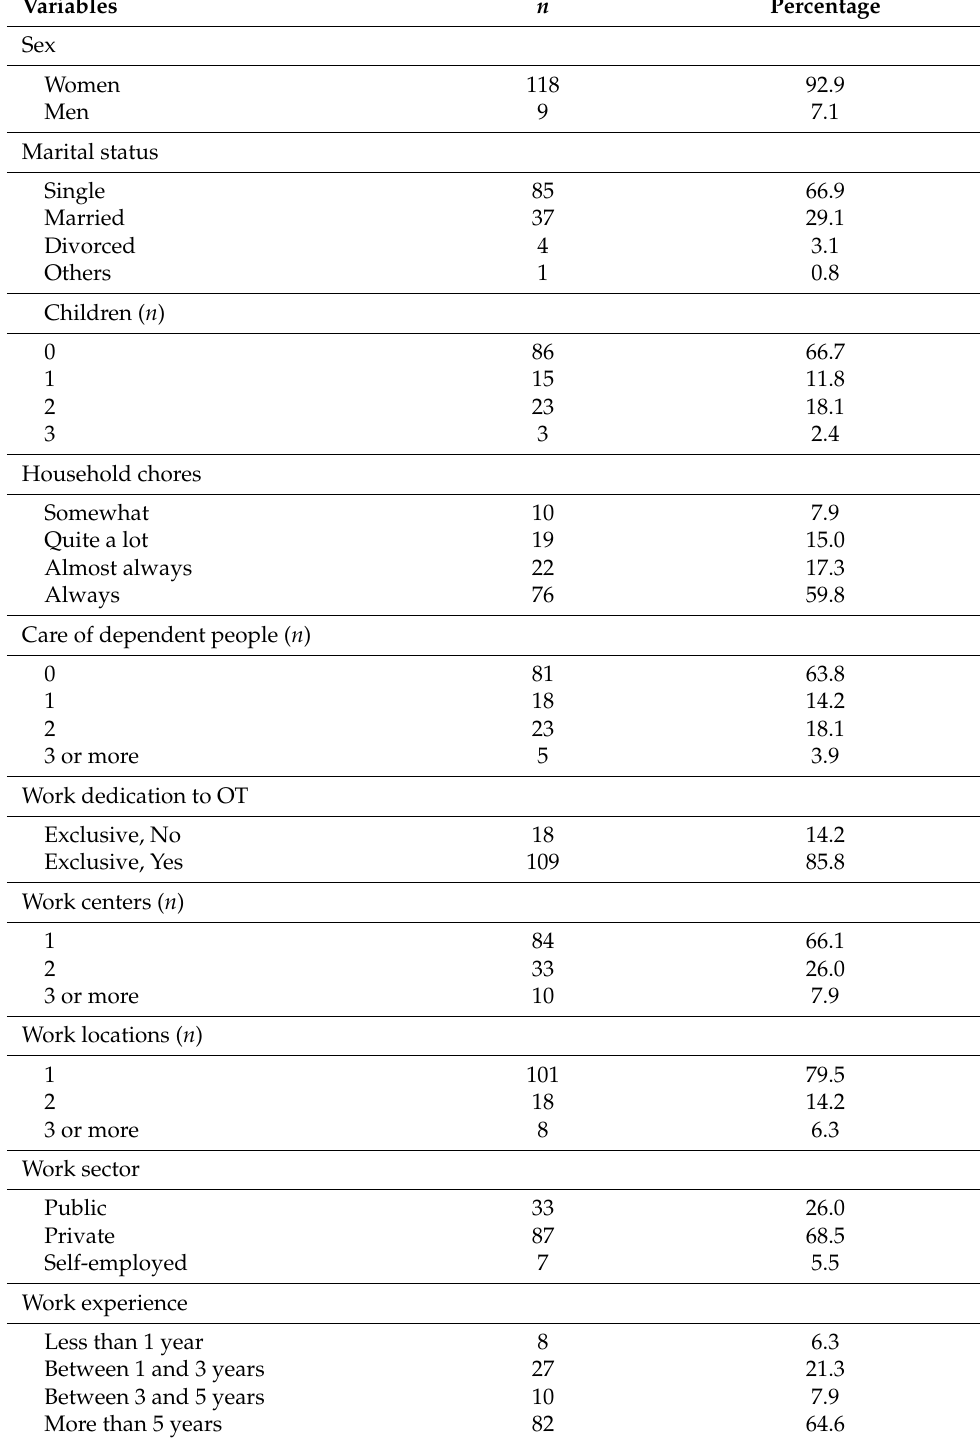
Table 1. Sociodemographic and professional characteristics of the sample (N =